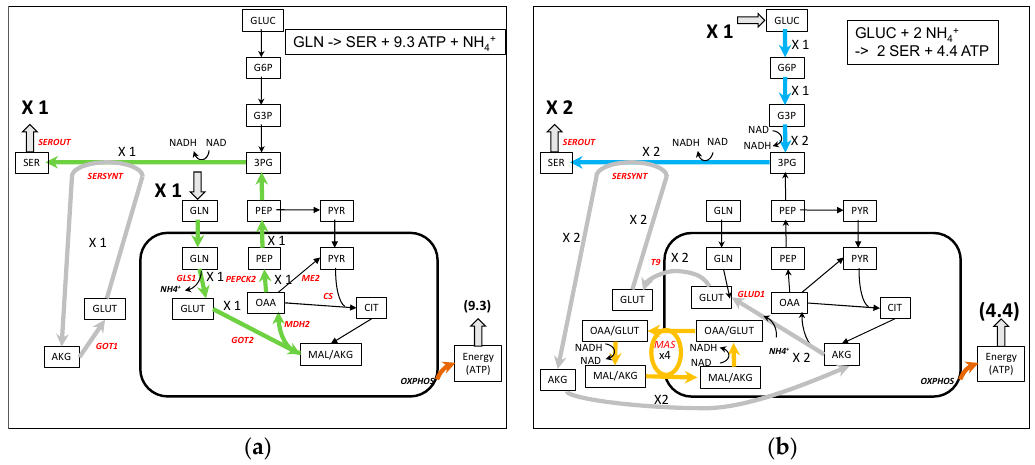
Figure 7. A simplified representation of serine synthesis from glutamine ( a ) and glucose ( b ). In light gray, is the recycling of glutamate for serine synthesis. The complete model is in Figure S7 in the Supplementary Materials.